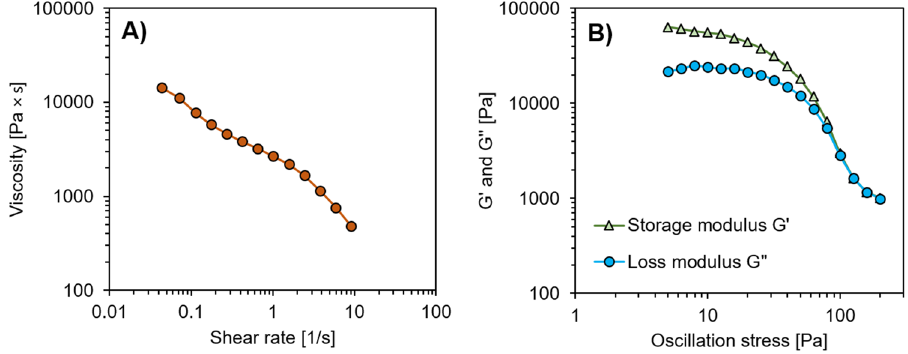
Figure 2. ( A ) Rheological behavior of the paste showing shear-thinning behavior, and ( B ) dynamic mechanical analysis at 1 Hz showing the yield point at 160